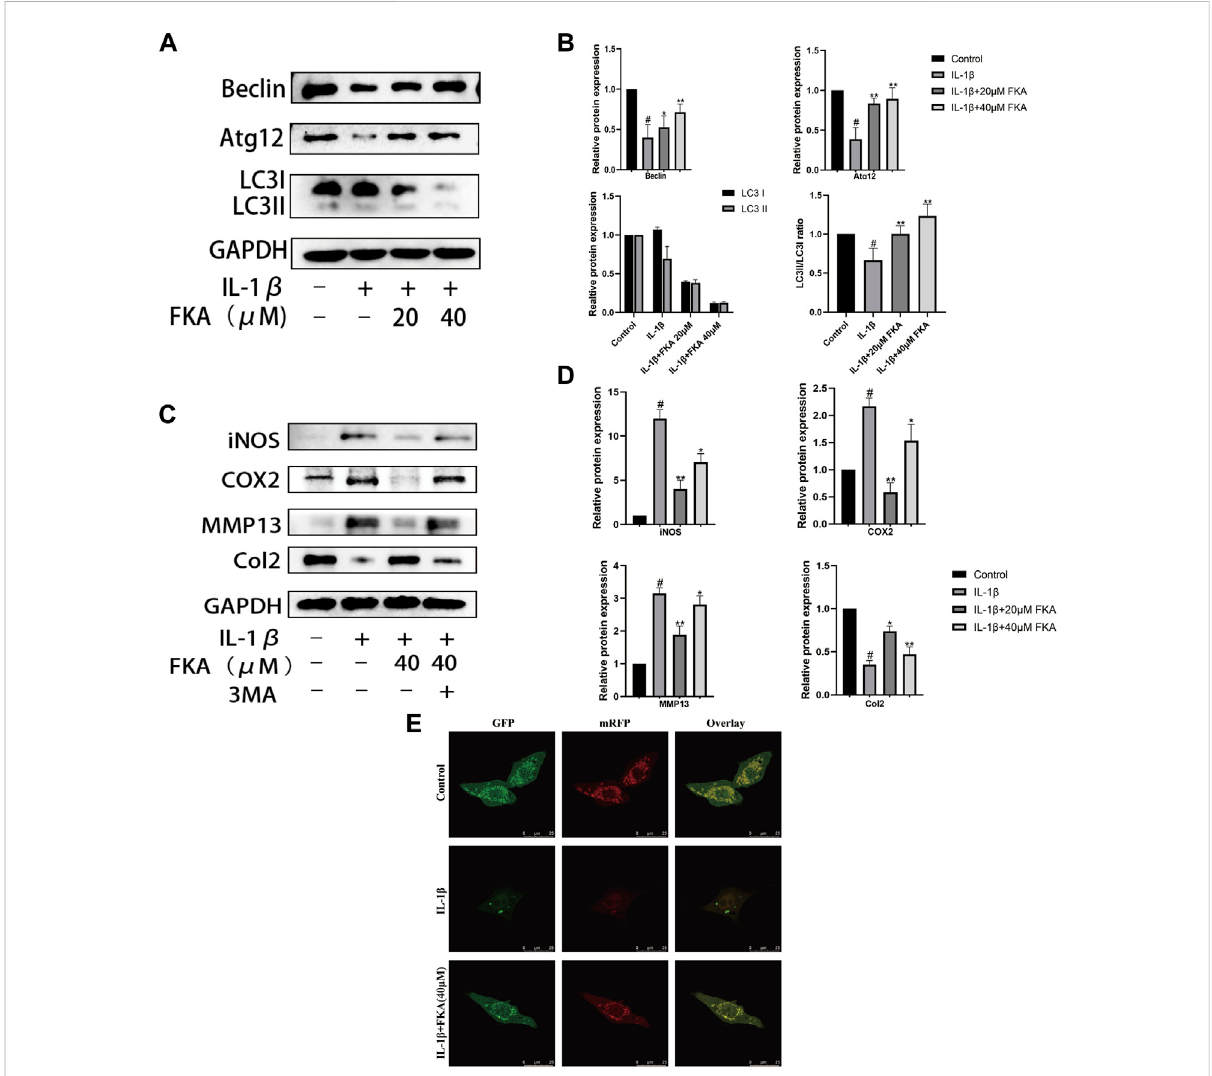
FIGURE 5 FKA regulates IL-1 β -induced autophagy-related gene expression in chondrocytes (A) Western blot results show Beclin, ATG12, and LC3I/LC3II expression in chondrocytes. (B) Quantitative analysis of protein expression. (C) Effect of FKA on autophagy in chondrocytes after treatment with the autophagy inhibitor 3 MA. (D) Quantitative analysis of protein expression. (E) After 5 ng/ml of IL-1 β was added for treating the cells for 24 h in the absence or presence of 40 µM FKA, detection of autophagy in chondrocytes transfected with RFP-GFP-LC3-adenovirus was performed (scale bar 25 μ m). Autophagosomes denoted by the green dots, autophagolysosomes denoted by the red dots. The values are presented as means ± SD ( n = 3). # p < 0.05 vs control group; * p < 0.05 and ** p < 0.01 vs IL-1 β